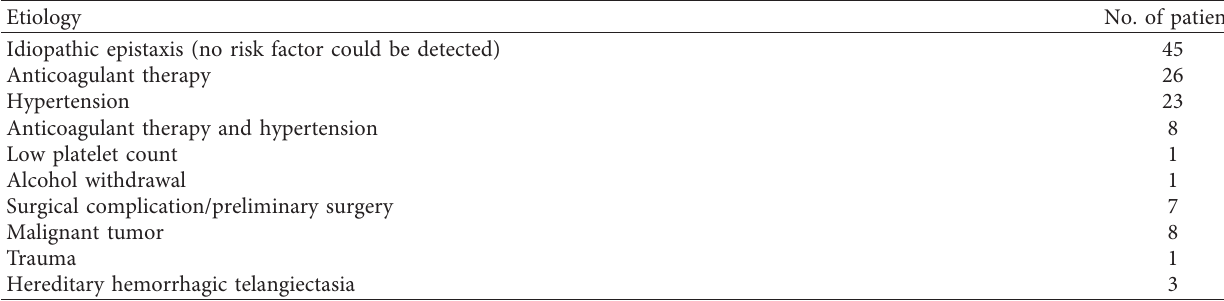
Table 3: Etiologies of epistaxis.